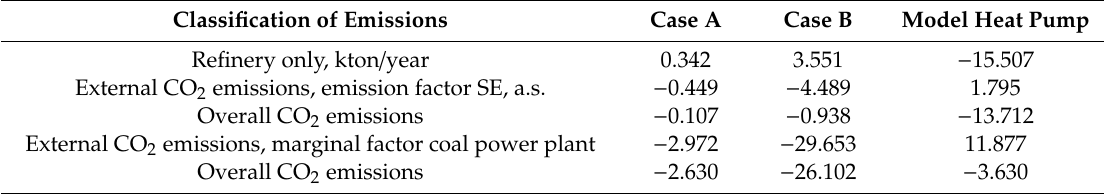
Table 11. CO 2 emissions balance on the refinery level and the overall balance.